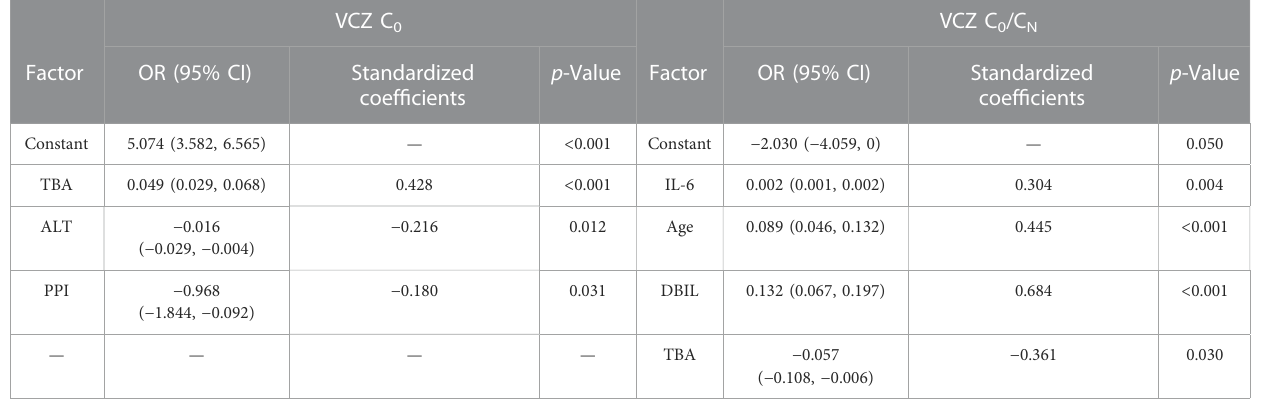
TABLE 3 In fl uencing factor of VCZ C 0 and C 0 /C N in younger adult